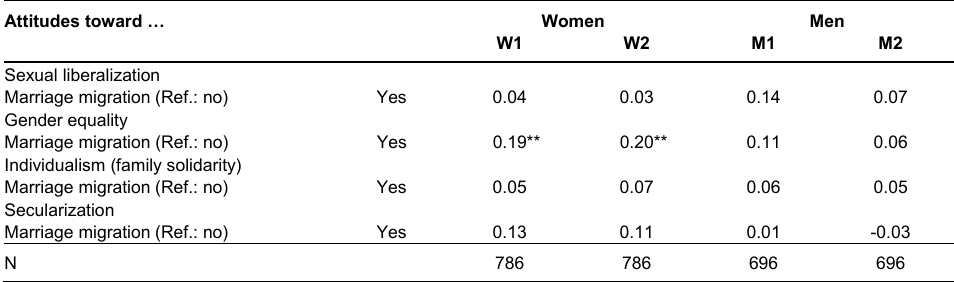
Results of linear regression models for attitudes among exogamous natives Attitudes toward … Women Men